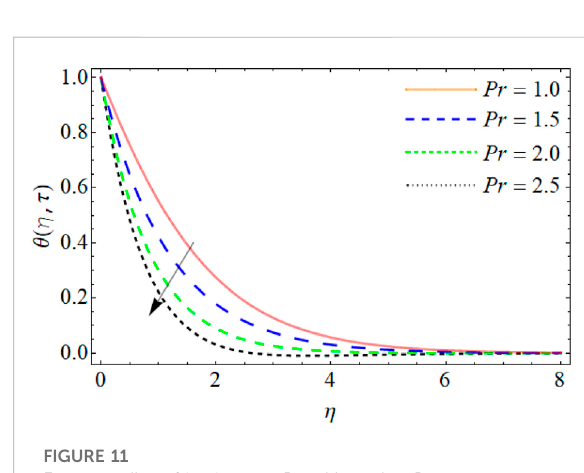
FIGURE 11 Energy outlines θ ( η , τ ) versus Prandtl number Pr